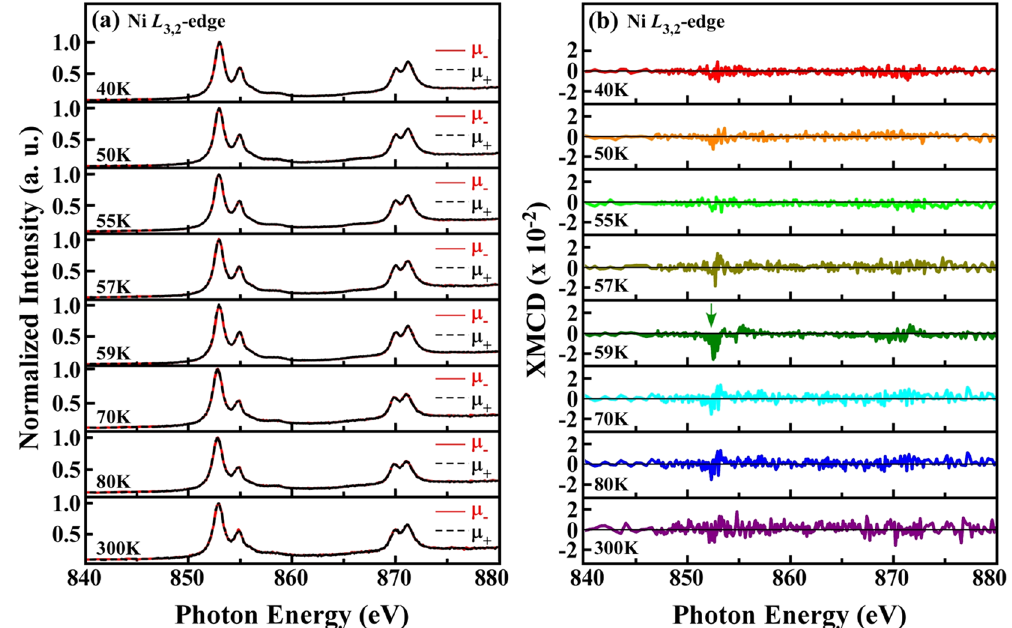
Figure 4. ( a ) Temperature-dependent X-ray absorption spectra (with circularly polarized X-ray photons) of single crystal NTO at the Ni L 3,2 -edge in a magnetic field (100 Oe) applied parallel ( μ + ) and antiparallel ( μ − ) to the c -axis of NTO, and ( b ) corresponding XMCD spectra, calculated from the difference in the X-ray absorption spectra obtained at the magnetic fields in two directions [( μ − − μ + )/( μ − + μ + )]. The prominent (negative) XMCD signal at the Ni L 3 -edge (indicated by the green arrow) at 59 K reveals the existence of FM interaction with Ni spins parallel to the c -axis in